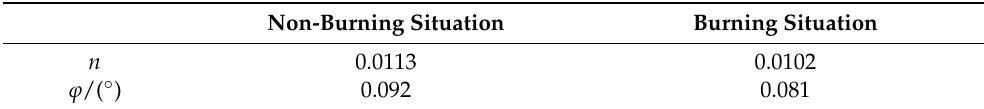
Table 5. Comparison of fitted values for burning and non-burning situations.